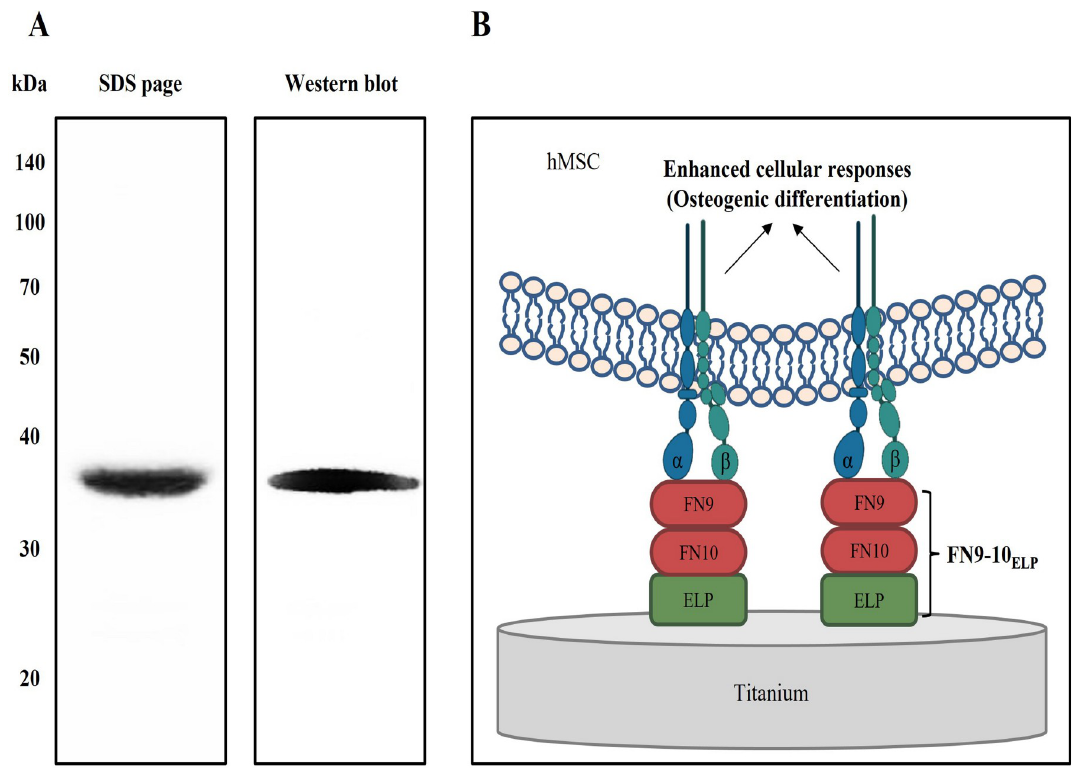
Fig 1. Expression of chimeric FN9-10 ELP and schematic illustration of bio-functionalization for enhanced cellular responses on titanium discs. (A) The purity and molecular weight of chimeric FN9-10 ELP were measured by 12% SDS-PAGE and Western blotting. The molecular weight shown is approximately 38 kDa. (B) Bio-functionalization of titanium discs using chimeric FN9-10 ELP to induce osteogenic differentiation of hMSCs.